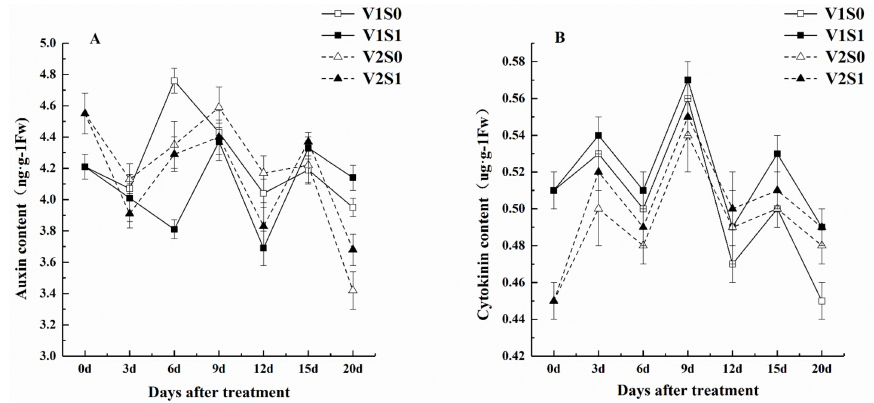
Figure 5. Changes of auxin and cytokinin contents in the spike under exogenous 6-BA treatment and the control in wheat. The e ff ects of 6-BA on auxin content ( A ) and cytokinin content ( B ) during 2016–2018, respectively.